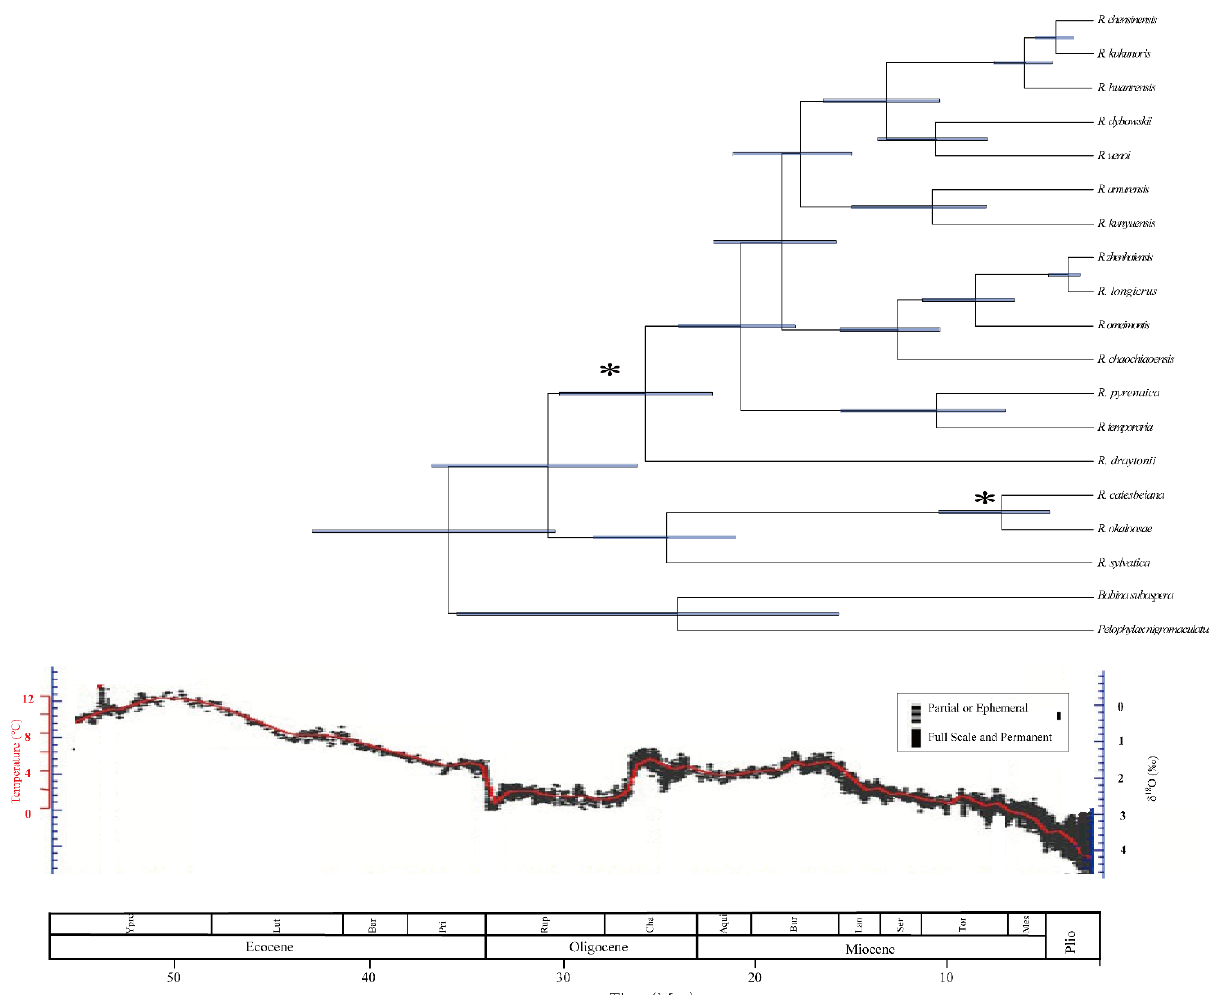
Figure 5. Time-calibrated phylogeny of Rana inferred from the complete mitogenomes. The symbol * indicates the calibration points. Horizontal blue bars represent 95% posterior density of the age on the node. The bottom axis is in million years ago (Mya). The climatic sequence of events including a global average δ 18 O curve (right-hand axis) derived from benthic foraminifera which mirrors the major global temperature trends